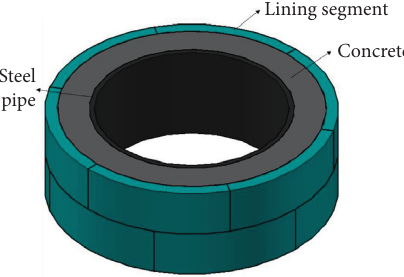
Figure 1: Diagram of composite